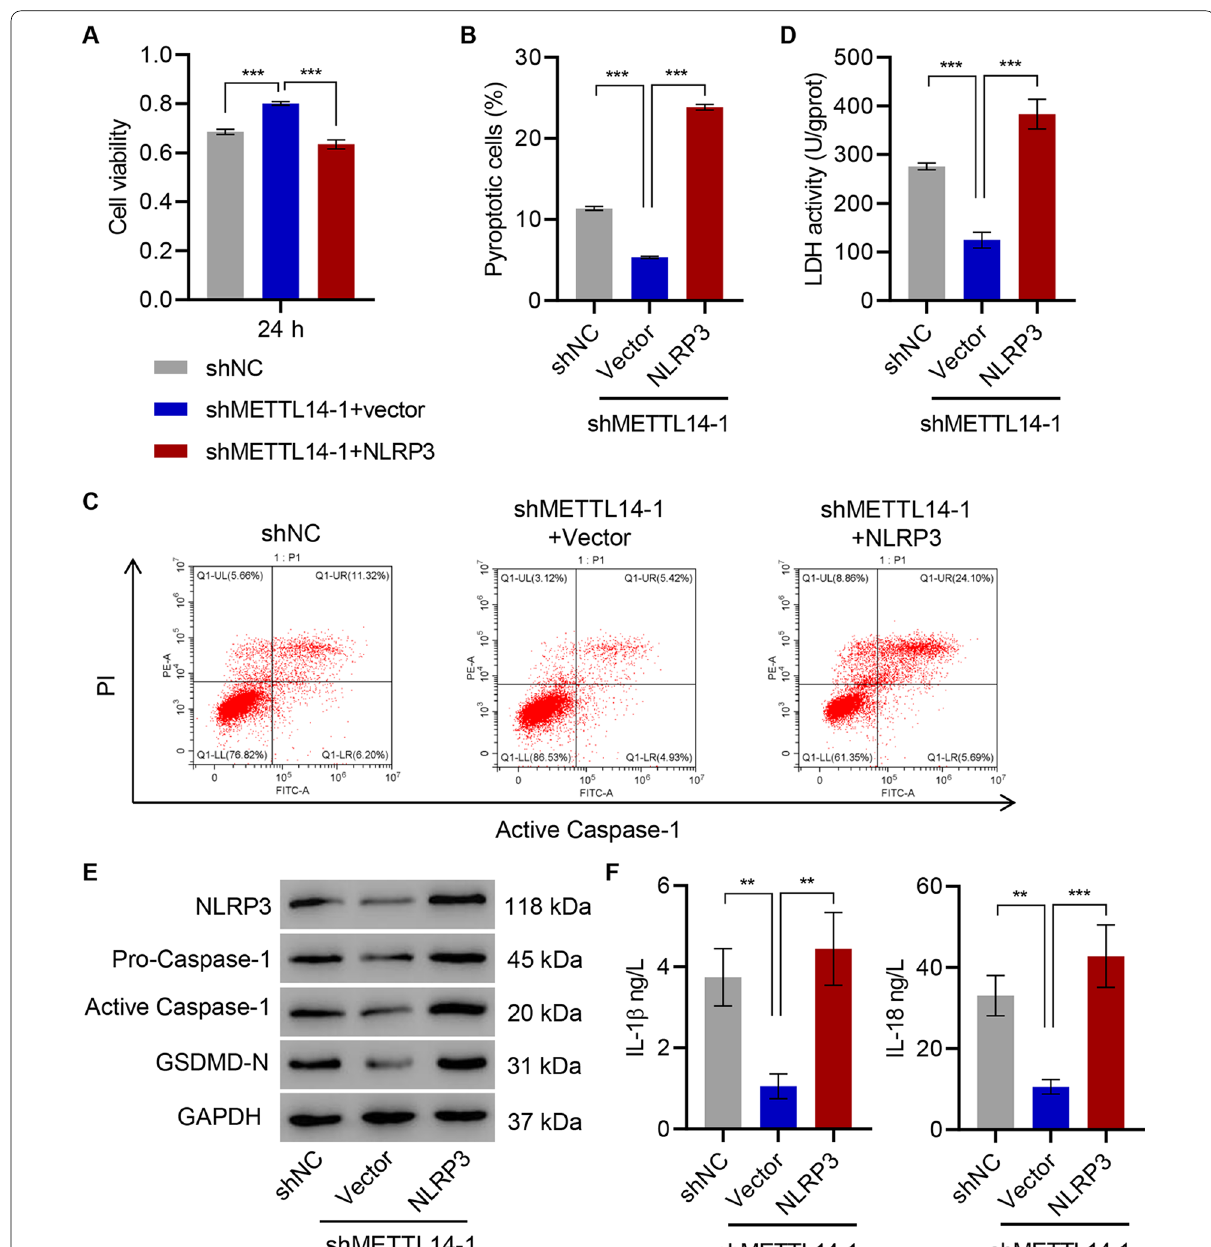
Fig. 6 The effects of METTL14 silencing on HNPC are inhibited by NLRP3 overexpression. A Cell viability, B , C pyroptosis, D LDH activity, E expression of NLRP3, caspase-1, and GSDMD-N, and F content of IL-1β and IL-18 were measured in D-HNPC transduced with METTL14 shRNA vector and NLRP3 expression vector. ** P < 0.01, *** P <